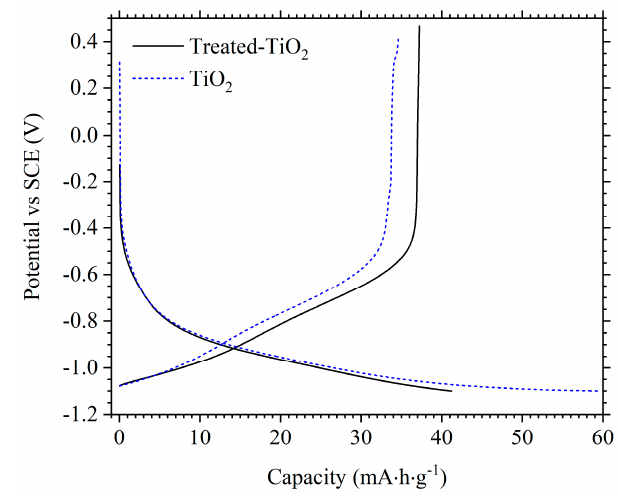
Figure 8. Voltage profiles of TiO 2 (blue-dash) and treated-TiO 2 (black) cycled to − 1.1 V vs. SCE at 1.0 A/g.